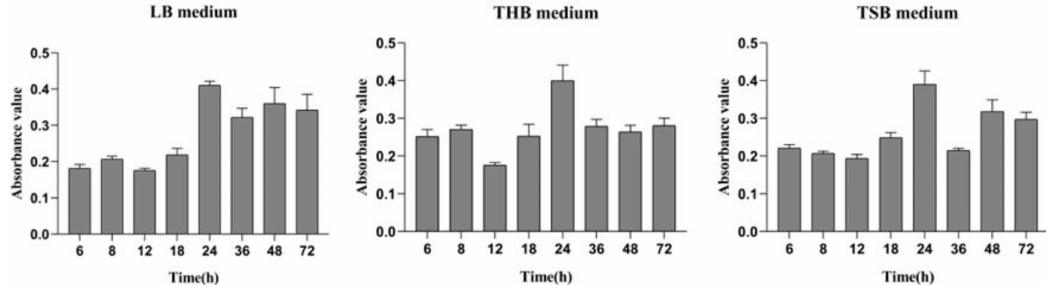
Figure 1. Di ff erential media for A. veronii biofilm